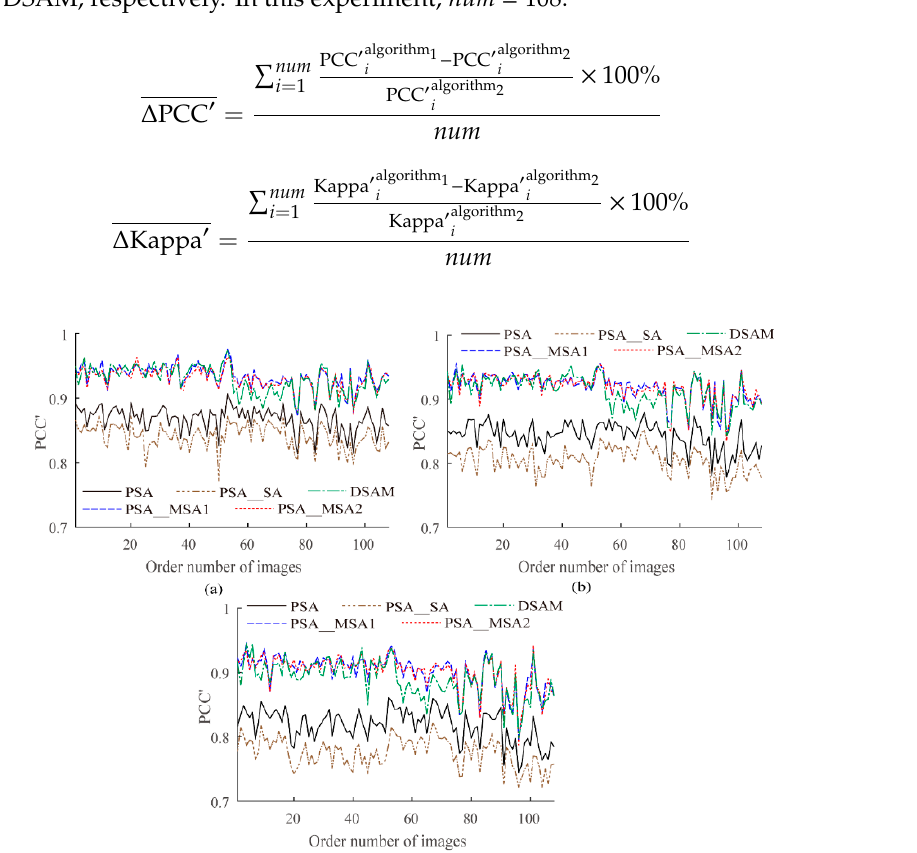
Figure 8. The improved PCC’ values (%) of different algorithms for the synthetic data set. ( a ) S = 8, ( b ) S = 10, ( c ) S = 12.